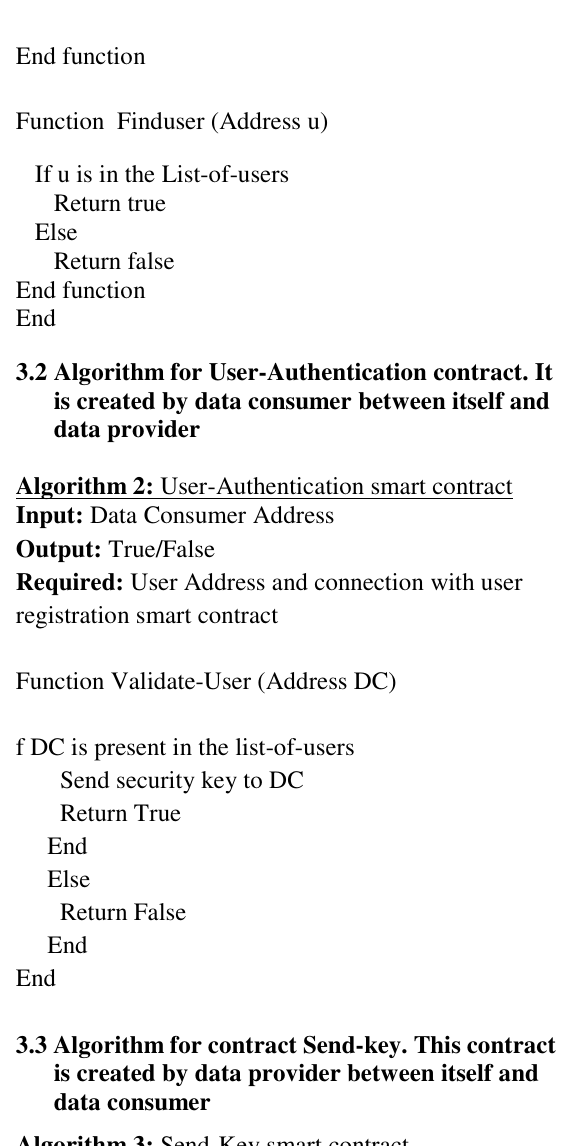
Algorithm 3: Send-Key smart